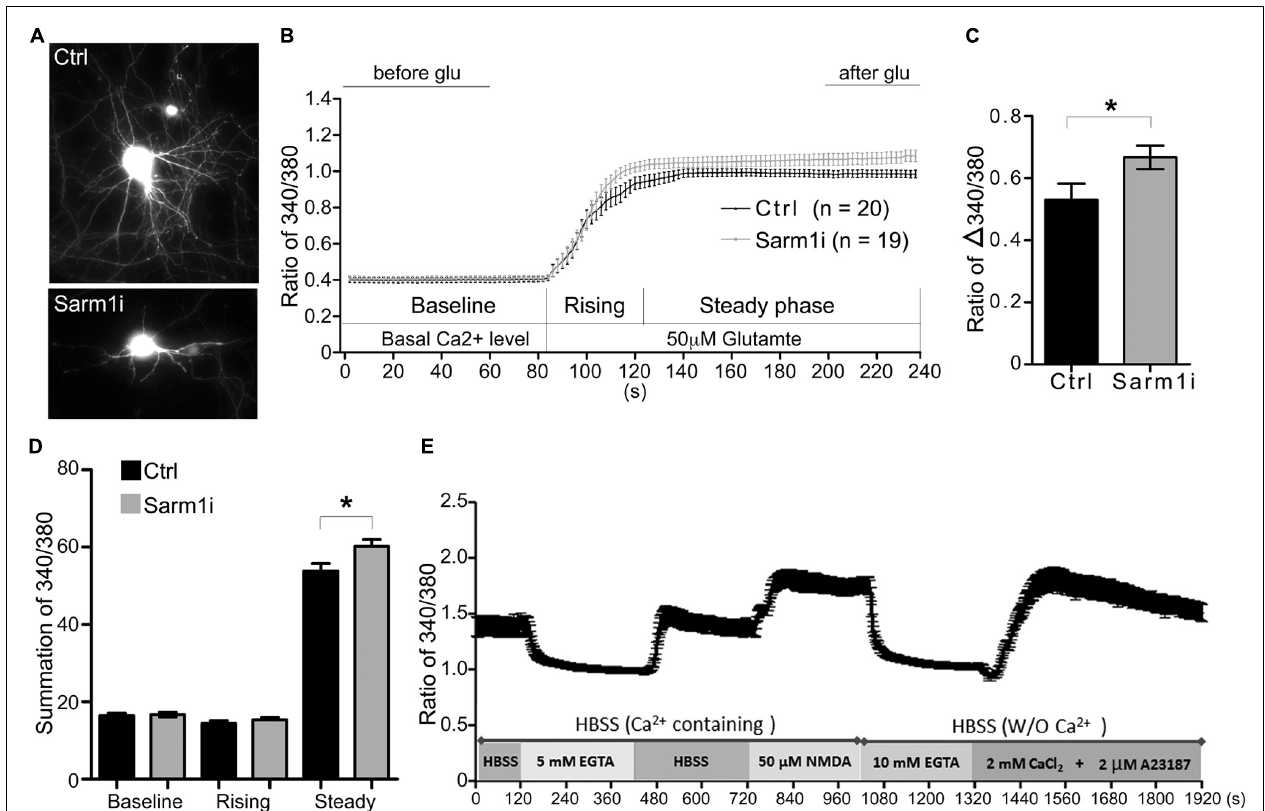
FIGURE 1 | Sarm1 knockdown enhances Ca 2+ influx after glutamate treatment in cultured hippocampal neurons. (A) Representative images of hippocampal neurons that have been transfected with a control vector (Ctrl) or a Sarm1 shRNA expressing construct (Sarm1i). (B) Calcium imaging after glutamate stimulation is shown. The Ca 2 + signal in the soma was monitored by Fura-2 for basal Ca 2 + levels between 0 and 90 s. After glutamate perfusion, a strong Ca 2 + influx response was induced, as shown by the dramatic increase in the 340/380 ratio. The entire response was separated into three phases (baseline, rising, and steady), as indicated.